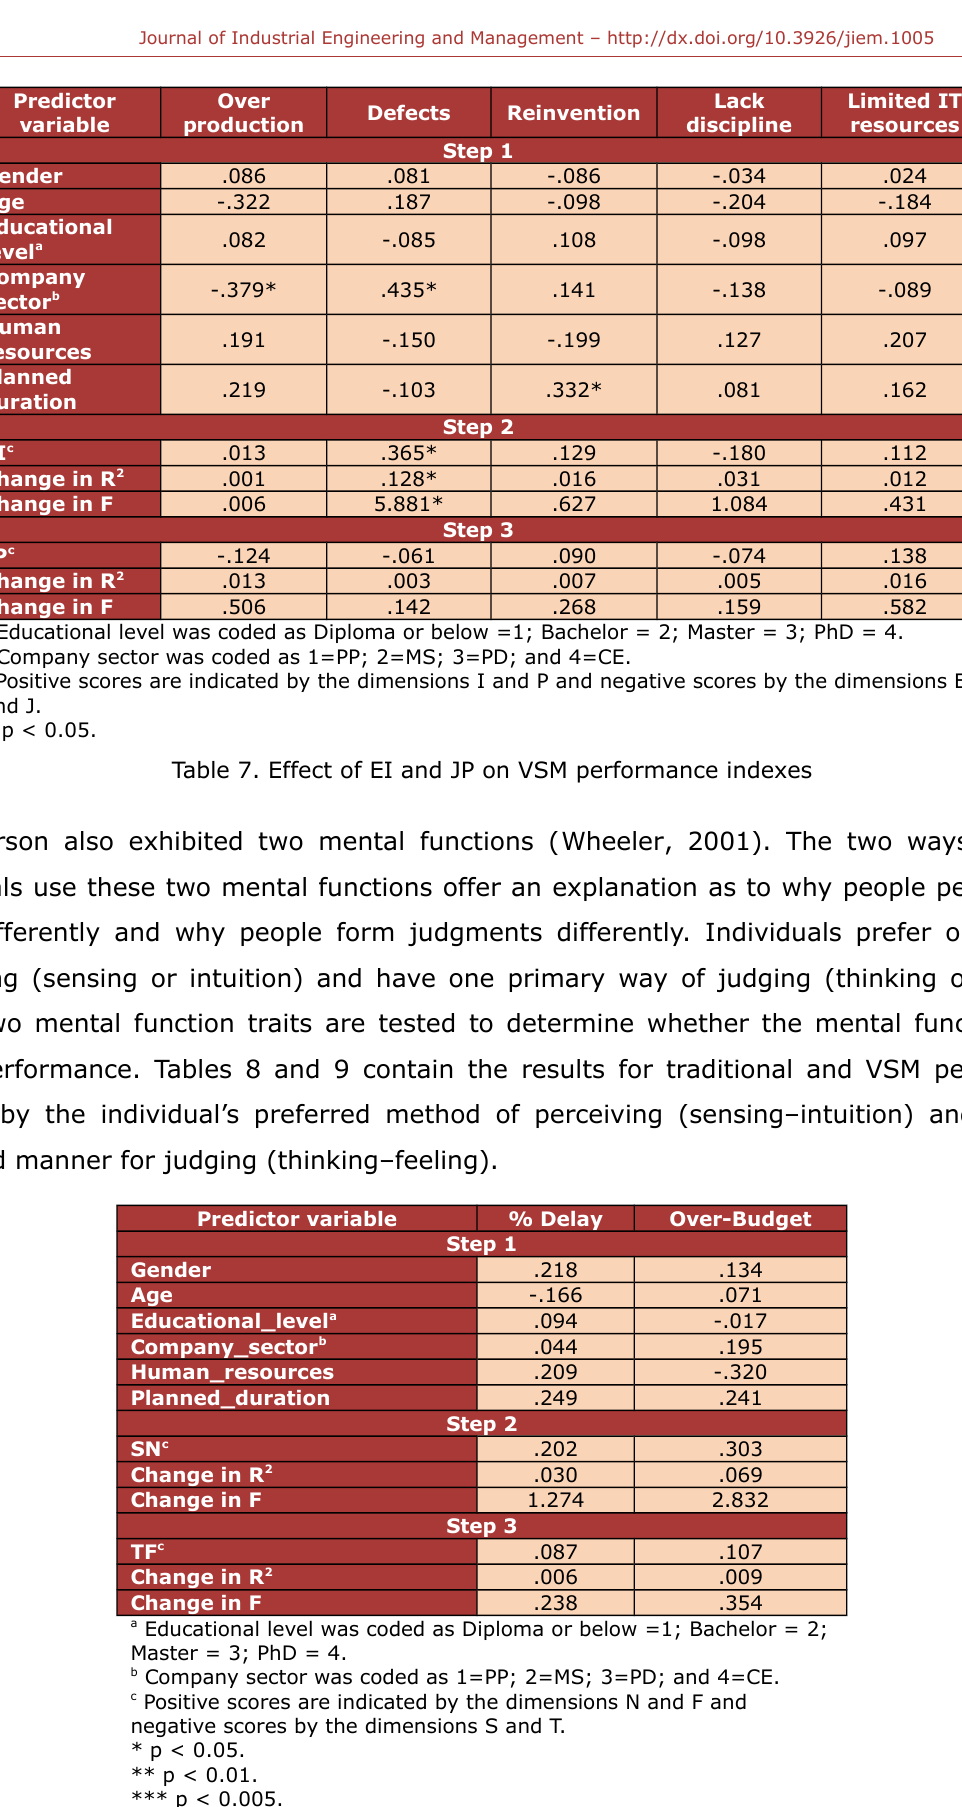
Table 8. Effect of SN and TF on traditional performance